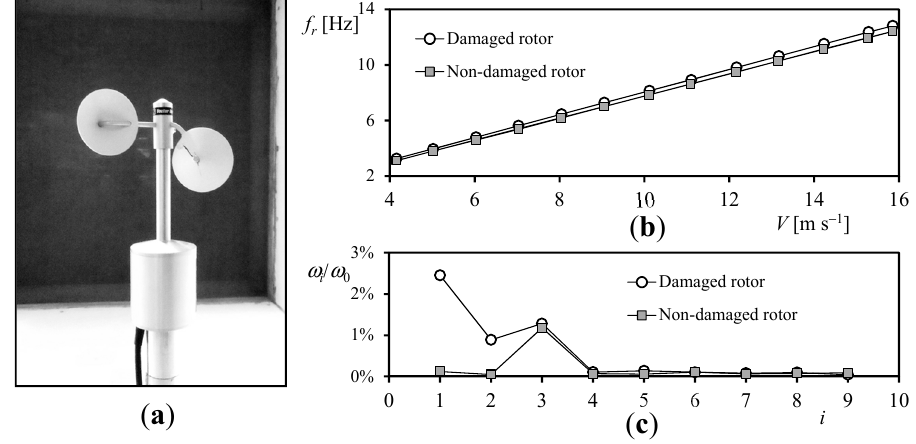
Figure 7. Damaged A100 LK cup anemometer after service period ( a ). Calibration curve of this anemometer compared to the one of that anemometer equipped with a non-damaged rotor ( b ). Fourier series decomposition of the aforementioned cup anemometer rotation rate along one turn of the rotor, see Equation (5) ( c ).